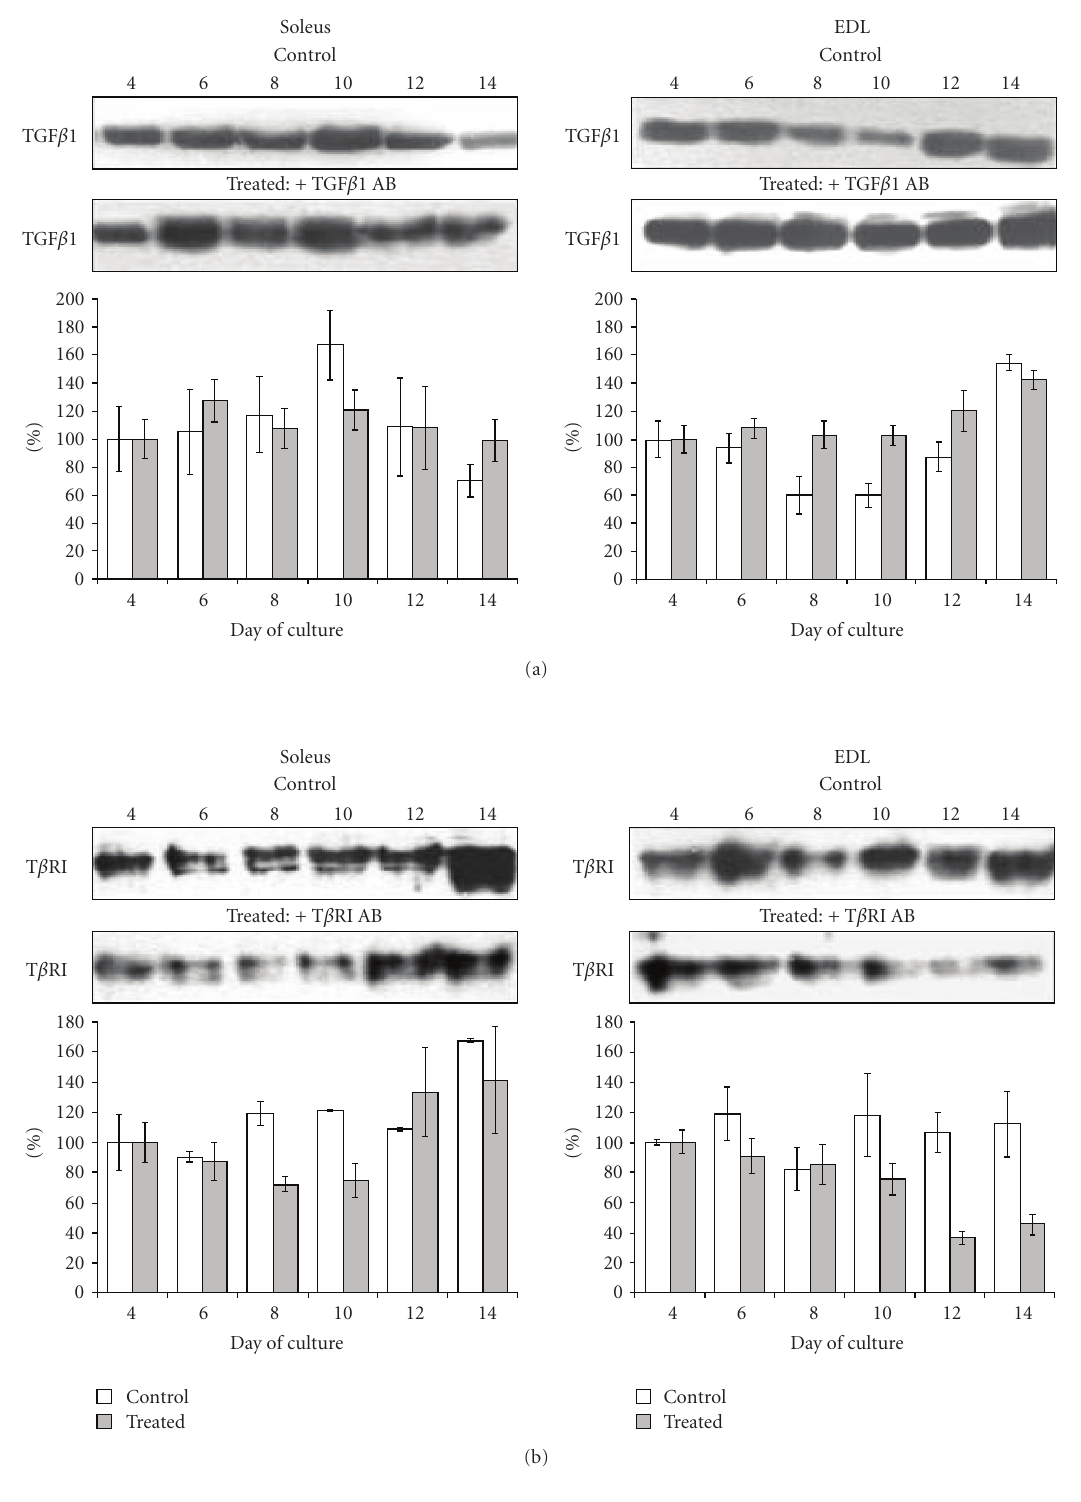
Figure 7: E ff ects of anti-TGF β 1 and anti-T β RI antibody treatments on TGF β 1 and T β RI protein levels in soleus and EDL derived myoblast cultures . Representative Immunoblots of (a) TGF β 1 or (b) T β RI from cultures of myoblasts derived from soleus and EDL muscles treated with anti-TGF β 1 and anti-T β RI, respectively. Band densities of membranes were scanned. Results are given as bars (white for control and gray for treated cultures) as a percentage of the density is found at day 4 in each condition. Each experiment was performed 3 times and the results were expressed as mean ± SE. Control of loading with α -tubulin content in the immunoblot was routinely checked and did not display significant variability upon samples (not